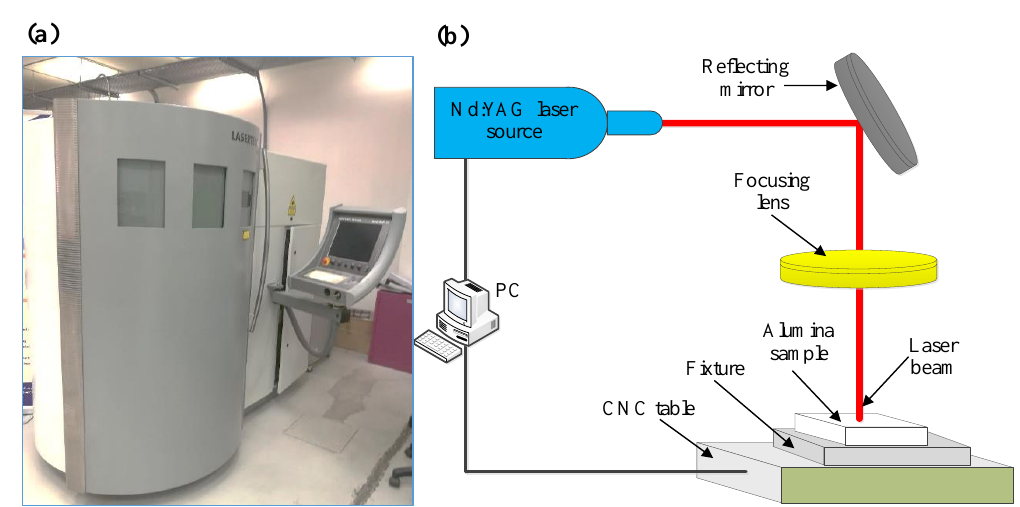
Materials 2020 , 13 , x FOR PEER REVIEW Figure 2. ( a ) Lasertec 40 machine, ( b ) schematic diagram of the laser system machine.